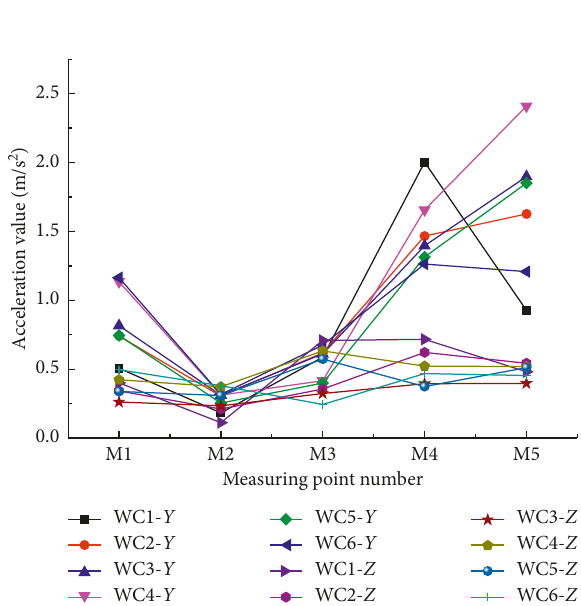
Figure 11: Peak acceleration values in Y and Z directions.